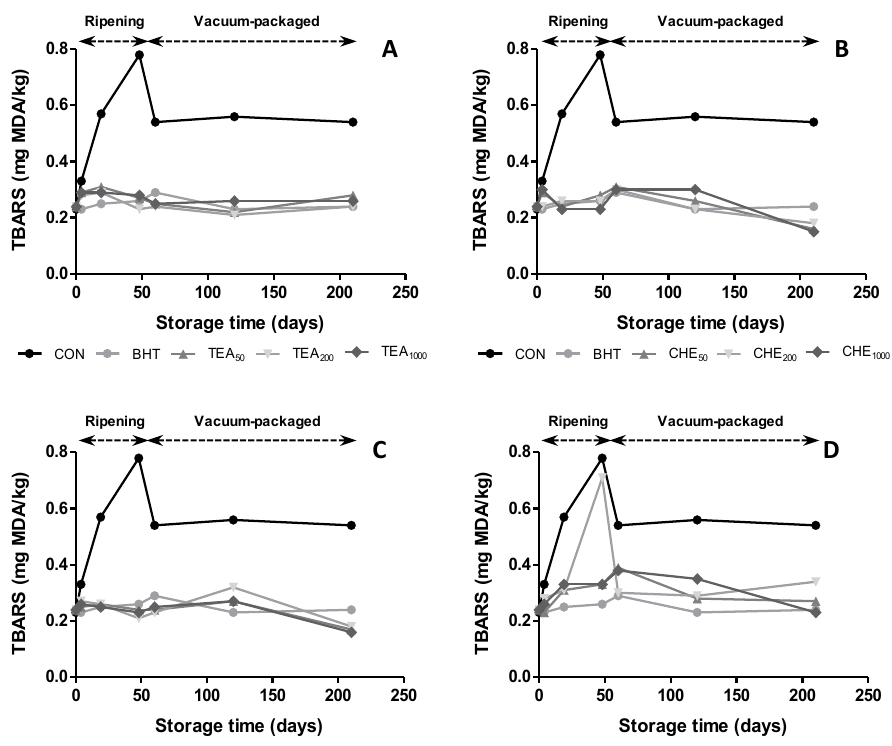
Figure 2. Evolution of thiobarbituric acid reactive substances (TBARS) in dry-cures sausages treated with BHT and natural antioxidants during ripening and vacuum-packaged